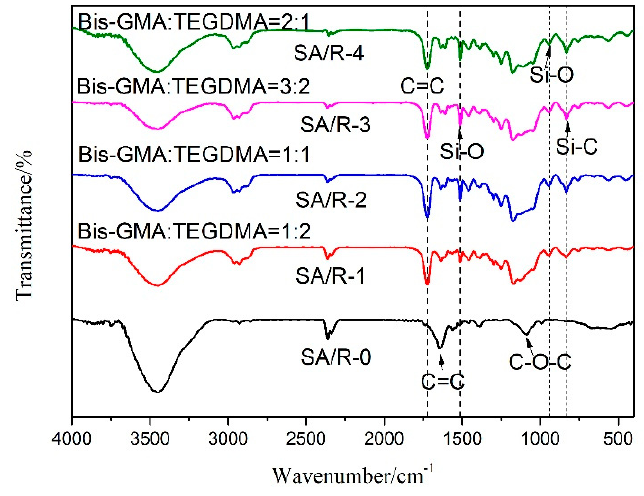
Figure 4. Infrared spectra of the silica aerogel/resin composites with different Bis-GMA: TEGDMA.